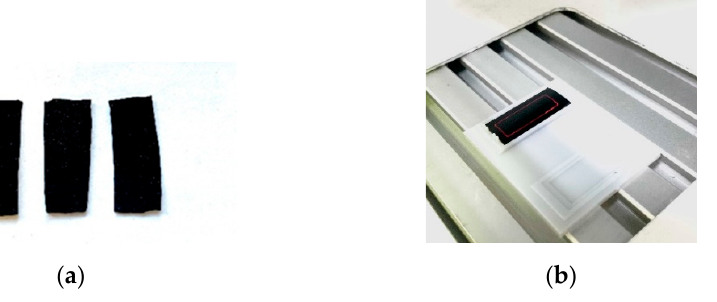
Figure 6. ( a ) Ecoflex/MWCNT composites with different concentration; ( b ) composite under a pilot laser beam.